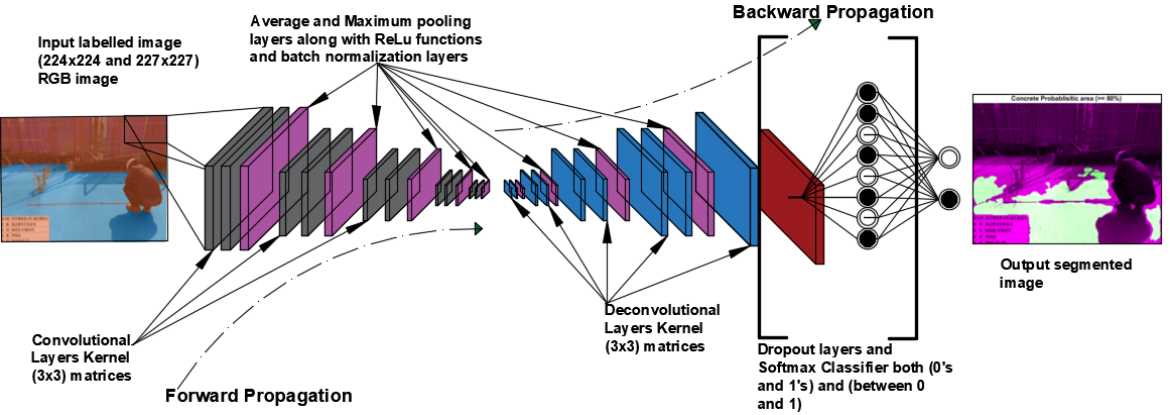
Figure 2. General architecture of CNN model for present work (modified from [17,29,30]).